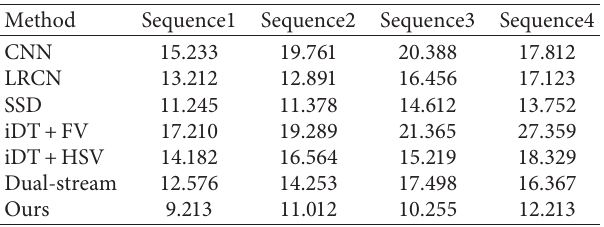
Table 4: Average absolute error of different methods on different sequences.